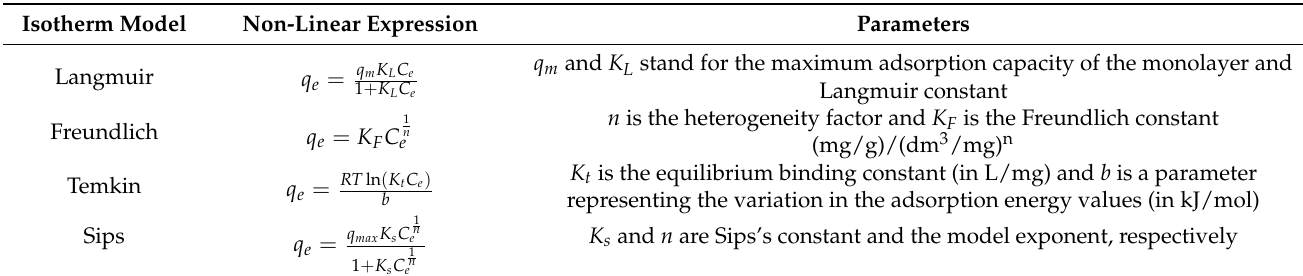
Table 2. The adsorption isotherm models and adsorption